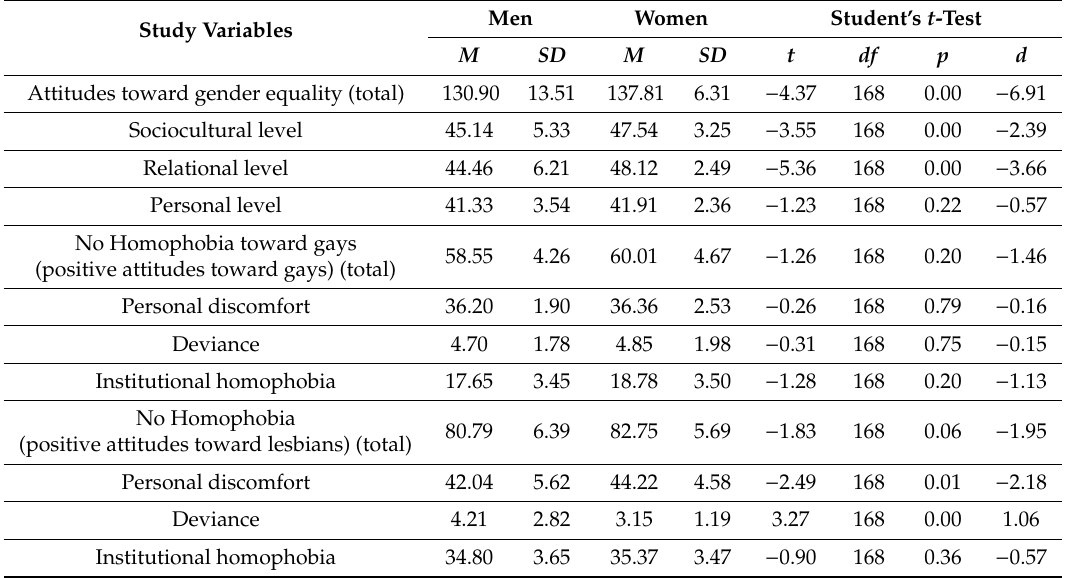
Table 2. Comparison of means (Student’s t -test) to determine di ff erences by sex for the study variables. Study